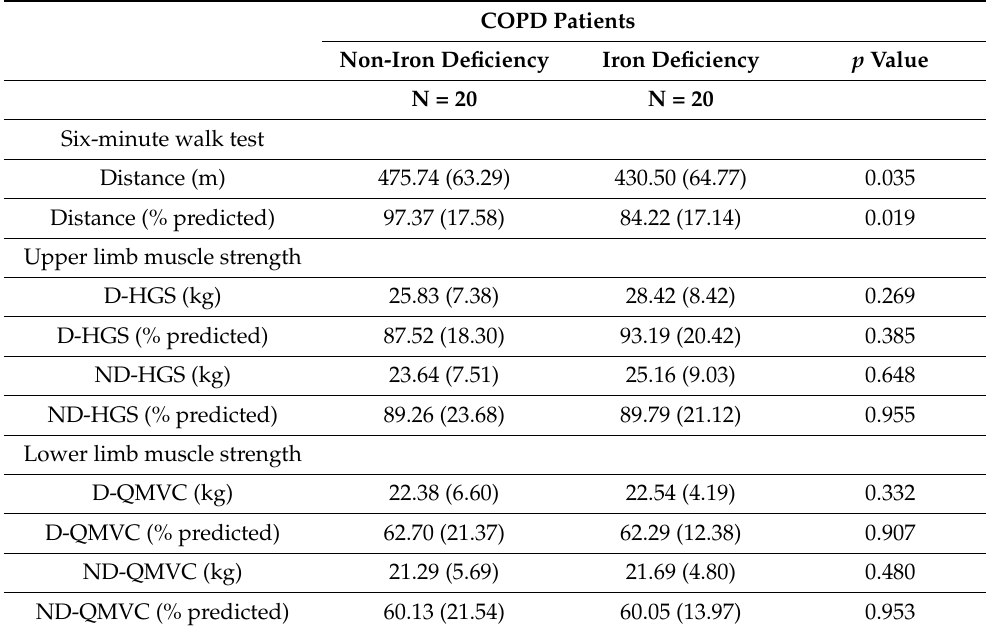
Table 2. Exercise and muscle function assessment of the study patients.